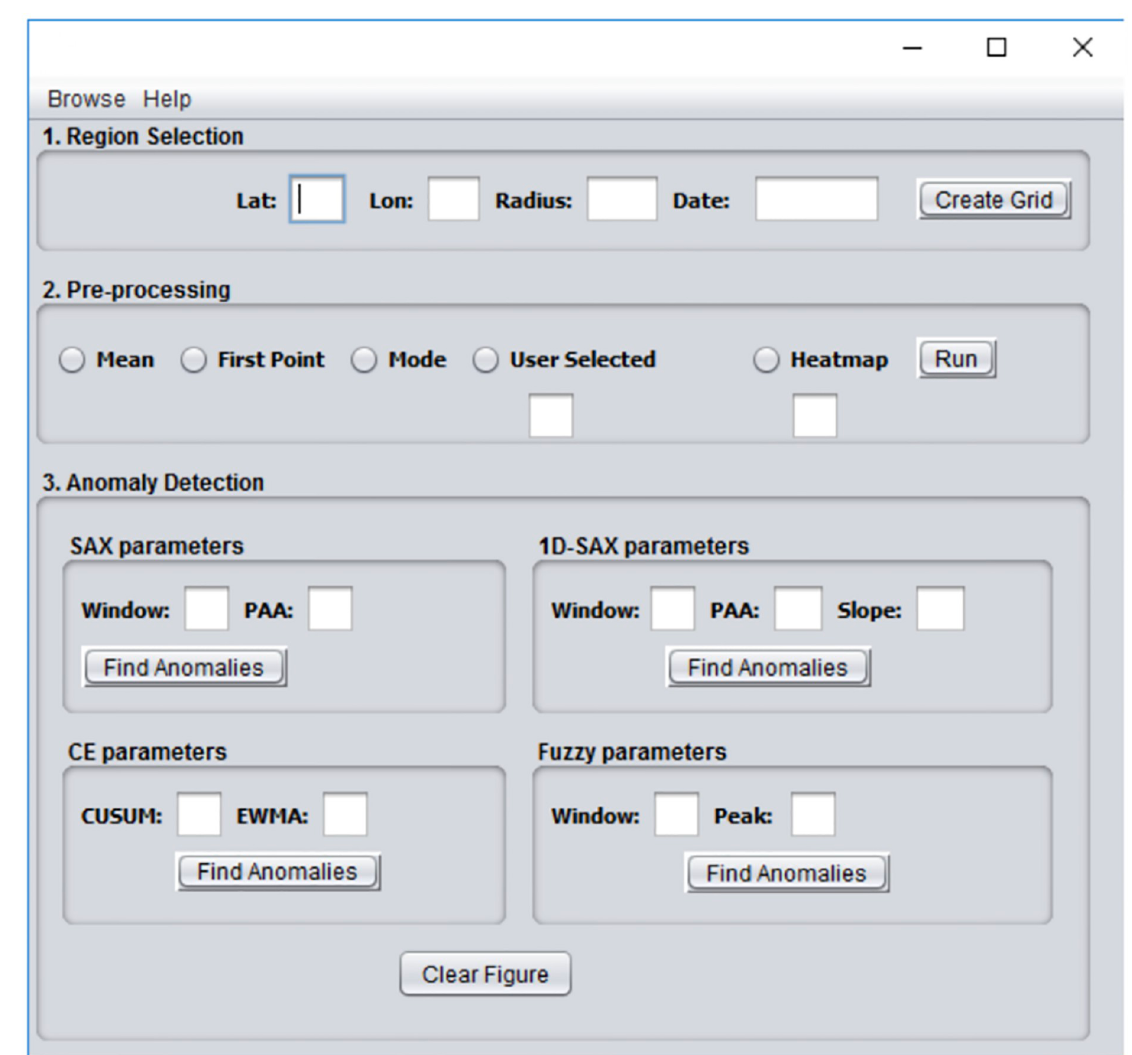
Fig 5. GUI of the developed software tool.